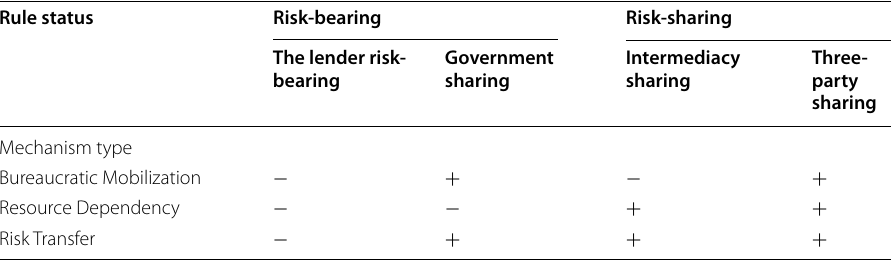
Table 2 Three pairs of mechanisms and the state of risk-sharing